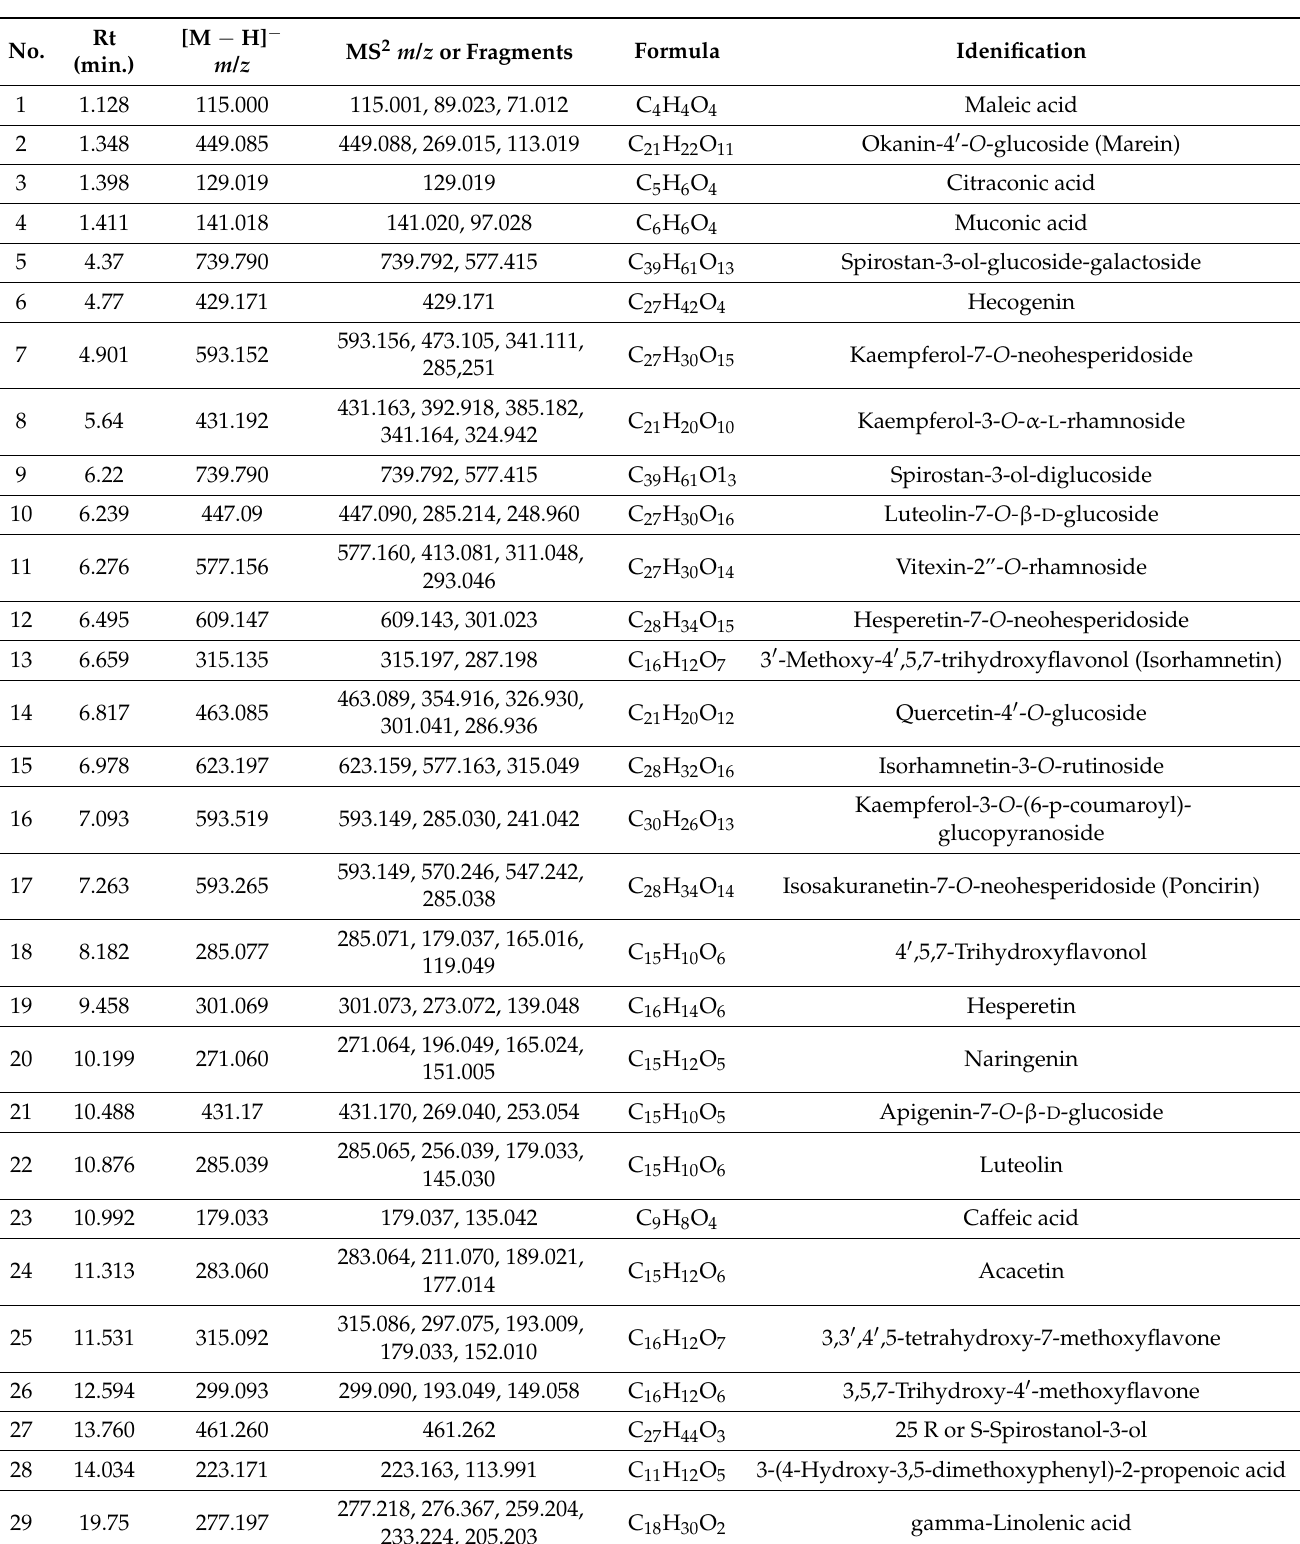
Table 1. Phytochemical profiling of YGME by LC-ESI-MS/MS in negative